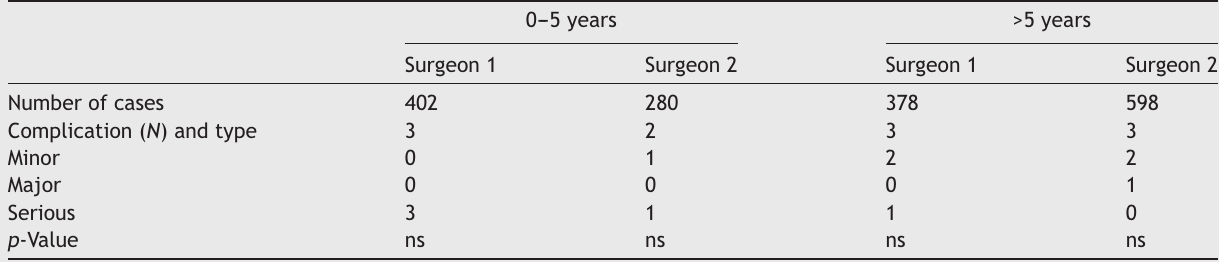
Percentage of operations done by beginners (0---5 years) and experienced (>5 years) surgeons with ophthalmic complications